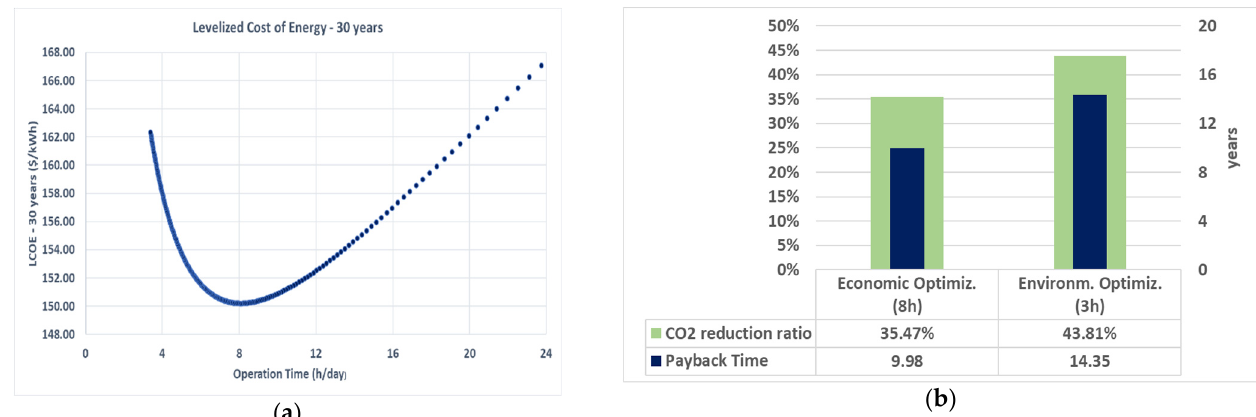
Figure 7. Optimization of Superheated Steam Gasification Process: ( a ) Economic optimum gasification operation time; ( b ) comparison between 8 h and 3 h gasification operation time.